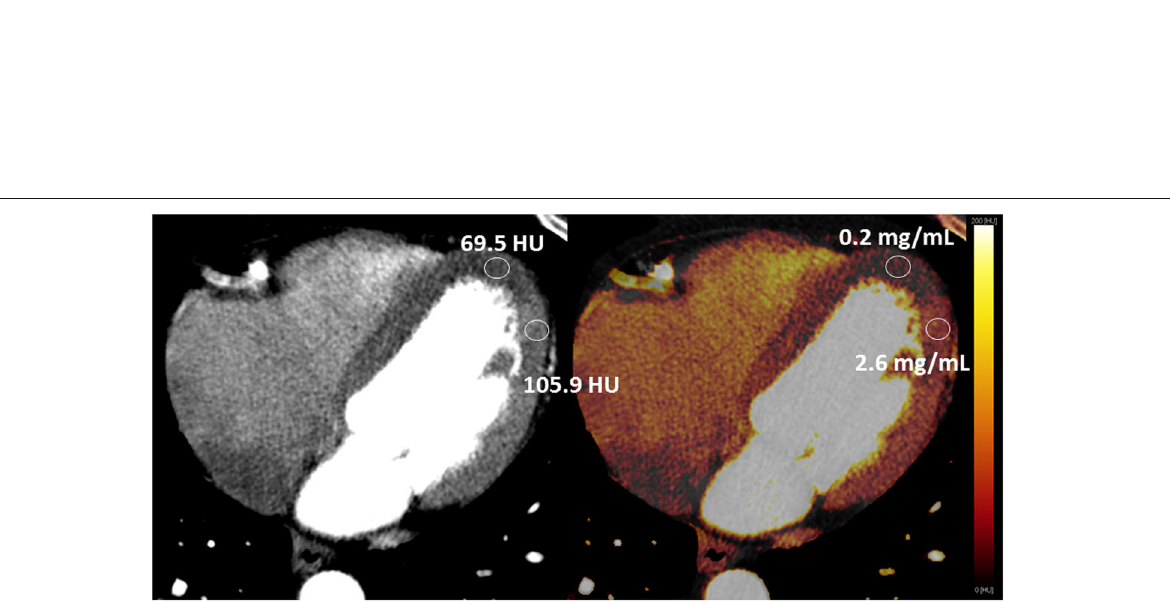
Fig. 5 The left image shows a grey scale DECT CCTA image with a clear difference in HU values between ischemic and normal myocardium. The right image represents the iodine map, showing a color-coded map of the iodine concentration, again showing a clear difference in iodine concentration between ischemic and normal